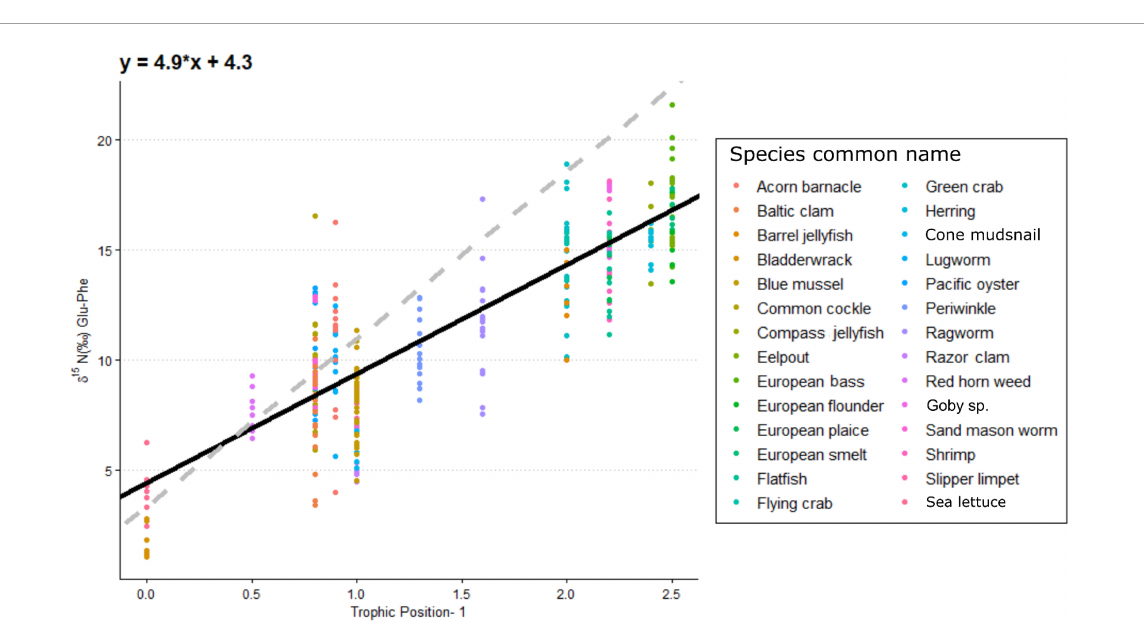
from POM was considerable ( > 0.5) for 11 of the 25 consumer species with R. pulmo (Barrel jellyfish) having the highest contribution (0.78 ± 0.1). For the two MPB end